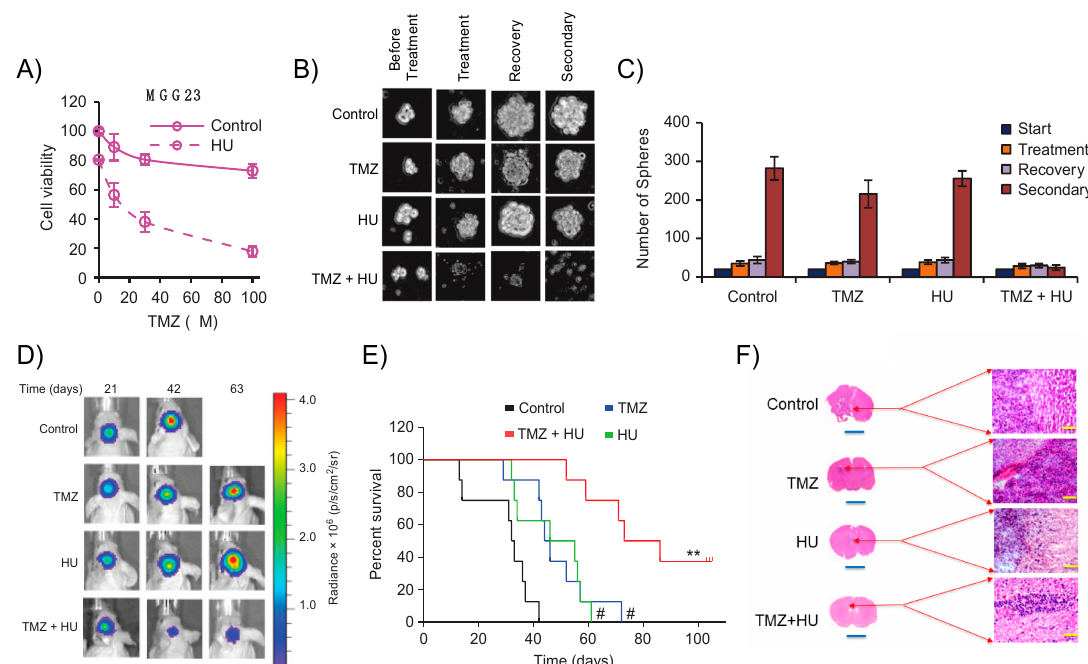
Figure 3. Tumor xenograft analysis workflow in vitro, in vivo, and ex vivo. ( A ) Patient-derived MGG23 GSCs were treated with different concentrations of temozolomide (TMZ; 100 nM to 1 mM) in the presence or absence of 30 µM hydroxyurea (HU), and cell viability was measured 3 days post-treatment. Results are shown as the mean ± SD where the vehicle control was set at 100%. ( B , C ) MGG23 neurospheres were treated with either DMSO, HU, TMZ, or HU + TMZ for 4 days. Spheres were counted, washed, and left without treatment for another 5 days to allow recovery. Recovered spheres were dissociated and plated in a new 48-well plate to measure secondary sphere formation 5 days later. Representative image from each treatment group is shown; scale bar, 200 µm ( B ). Total sphere numbers in the well were recorded at each event ( C ). ( D , E ) Mice-bearing MGG23 tumors were injected with DMSO, HU, TMZ, or TMZ + HU. Representative Fluc bioluminescence image of a single mouse from each group is shown over time ( D ) with corresponding Kaplan–Meier survival analysis comparing the two groups; # p < 0.05 vs. control, ** p < 0.01 TMZ + HU vs. TMZ ( E ). ( F ) Ex vivo histological analysis with Haematoxylin and Eosin staining 42 days after tumor injection. Reproduced and adapted with permission from Teng et al., Neuro-Oncology; published by Oxford University Press, 2018